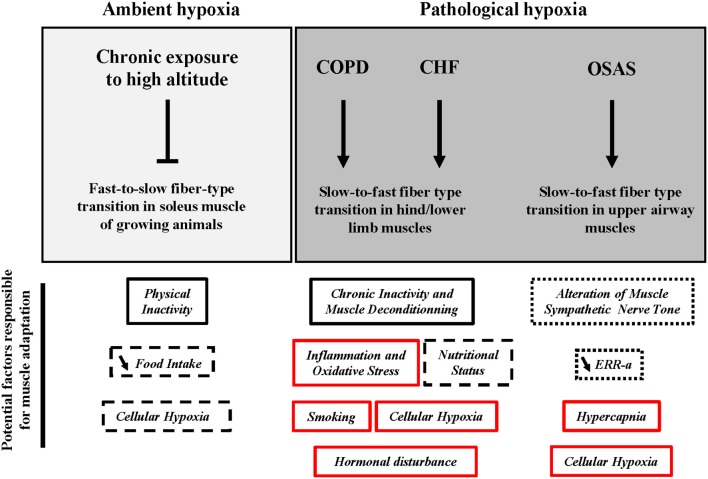
Potential factors responsible for the adaptation of skeletal muscle fiber type in response to chronic exposure to high altitude and under conditions of pathological hypoxia. COPD, chronic obstructive pulmonary disease; CHF, chronic heart failure; OSAS, obstructive sleep apnea syndrome; ERR- α, estrogen related receptor-alpha. Vertical arrow, activation; Vertical blunt arrow, inhibition; ↘, decrease.: Factor most likely responsible.: Factor possibly responsible.: Factor most unlikely responsible.: Role played unclear or unknown.